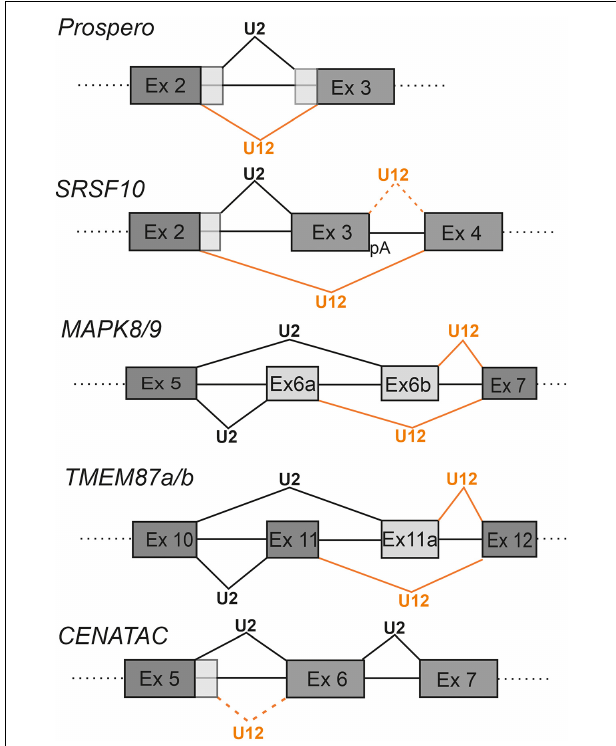
FIGURE 3 | Competition between minor and major spliceosomes. Examples of known genes utilizing adjacent U12-and U2-type introns in regulating gene expression. The U2-type splicing is indicated with black lines and U12-type splicing with orange lines. Alternative exon sequences are indicated with light gray shading. With SRSF10 an alternative poly-A site (pA) downstream of exon 3 is indicated. In the same panel, the rare U12-type splice site usage downstream of the exon 3 is indicated by dotted orange